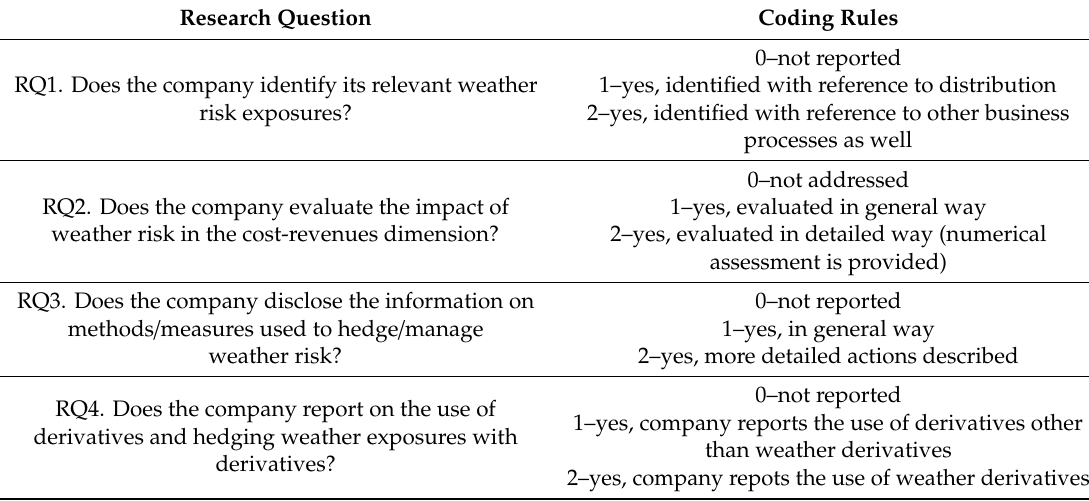
Table 2. Coding rules of textual information related to weather risk in